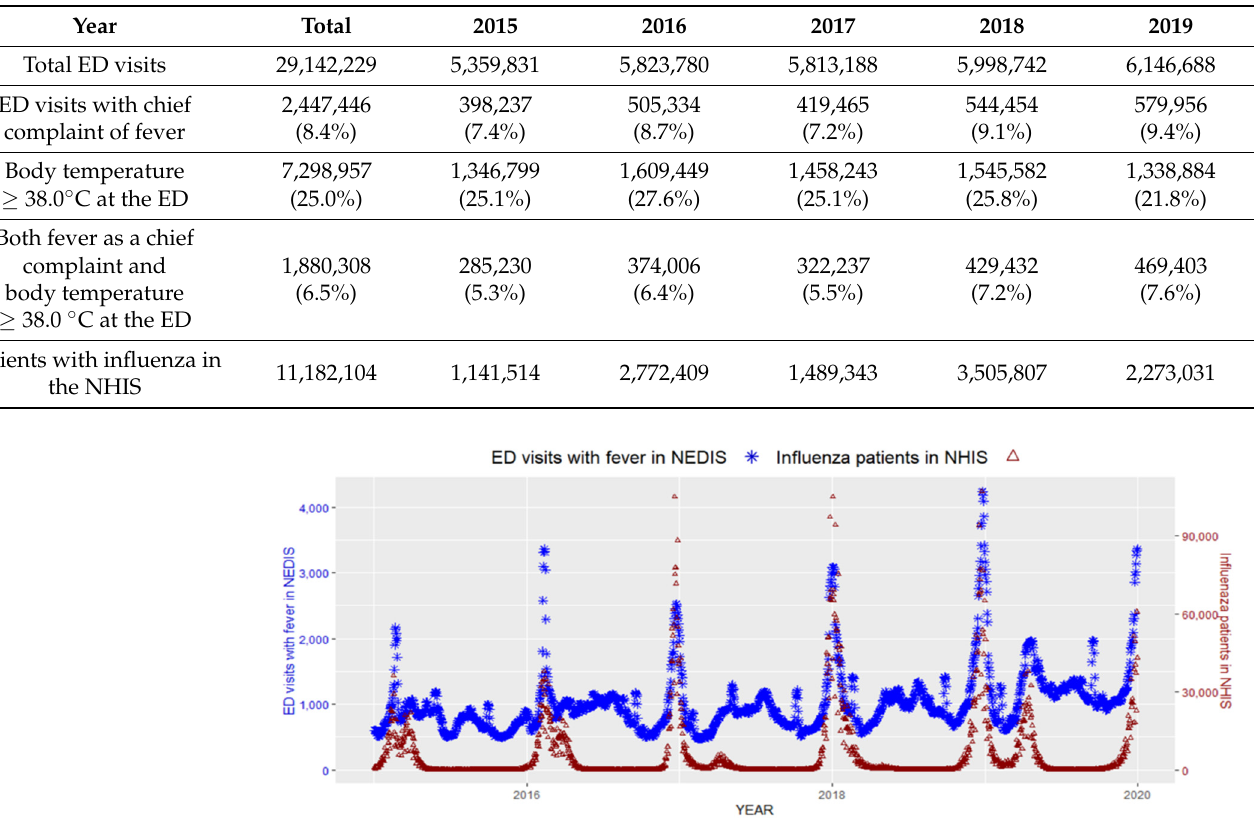
Figure 1. Seven ‐ day moving average of ED visits with fever and daily patients of influenza in the NHIS.